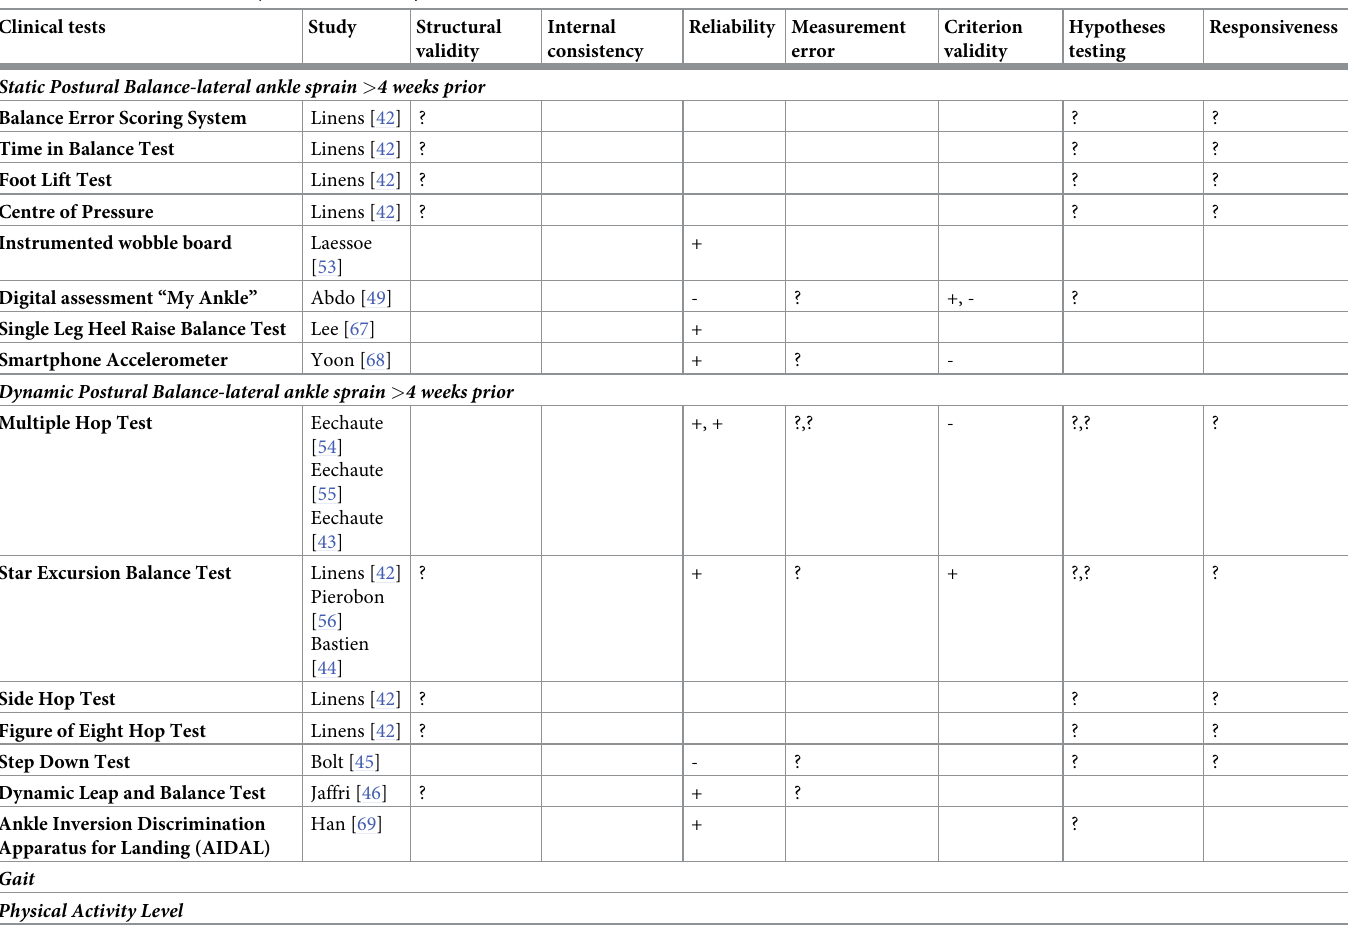
Table 5. Overview table of study results. Secondary outcomes.